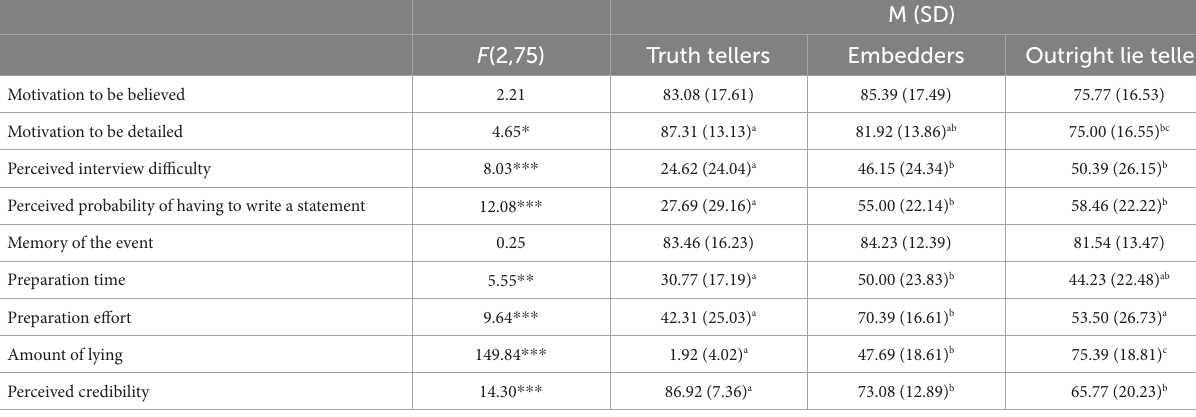
TABLE 1 Manipulation checks and post-interview questionnaire statistics.